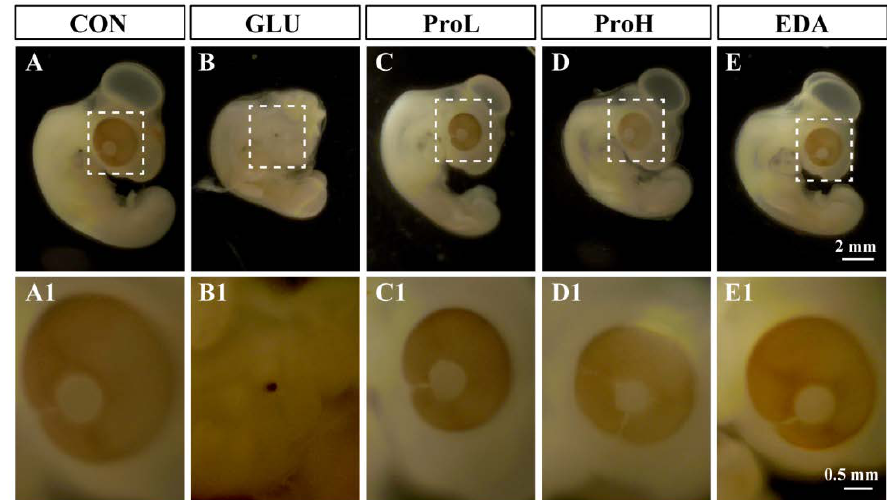
Figure 2. Morphology images of embryo eye development. Stereoscopic microscope measurement of embryo eyes. Scale bars of ( A – E) : 2 mm. Scale bars of ( A1 – E1) : 0.5 mm. CON: control, GLU: high glucose, ProL: 1 nmol/egg proanthocyanidins, ProH: 10 nmol/egg proanthocyanidins, EDA: edaravone.